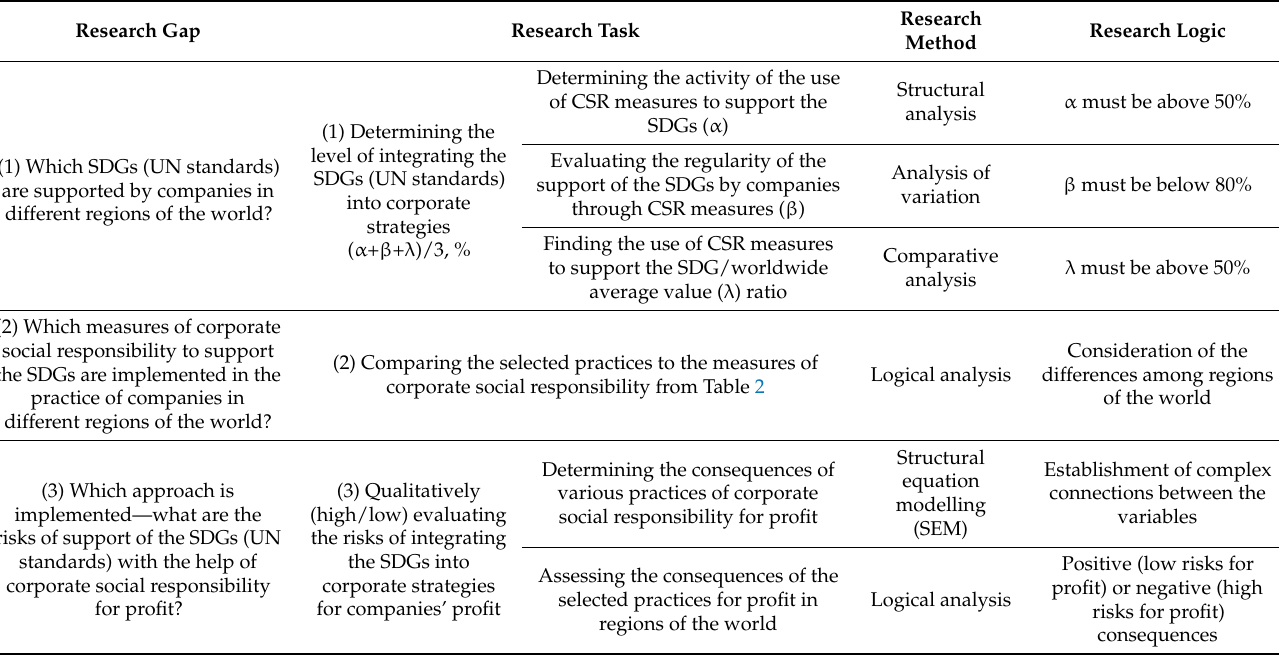
Table 3. The strategy of the